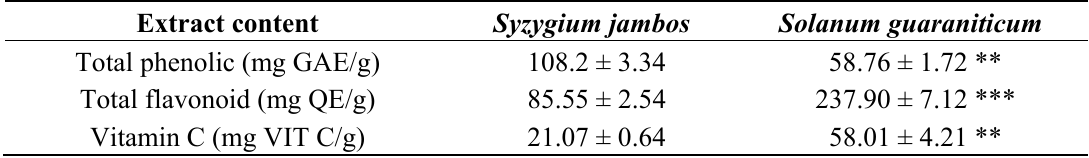
Table 1. Total phenols, total flavonoids and vitamin C contents in aqueous extracts of Syzygium jambos and Solanum